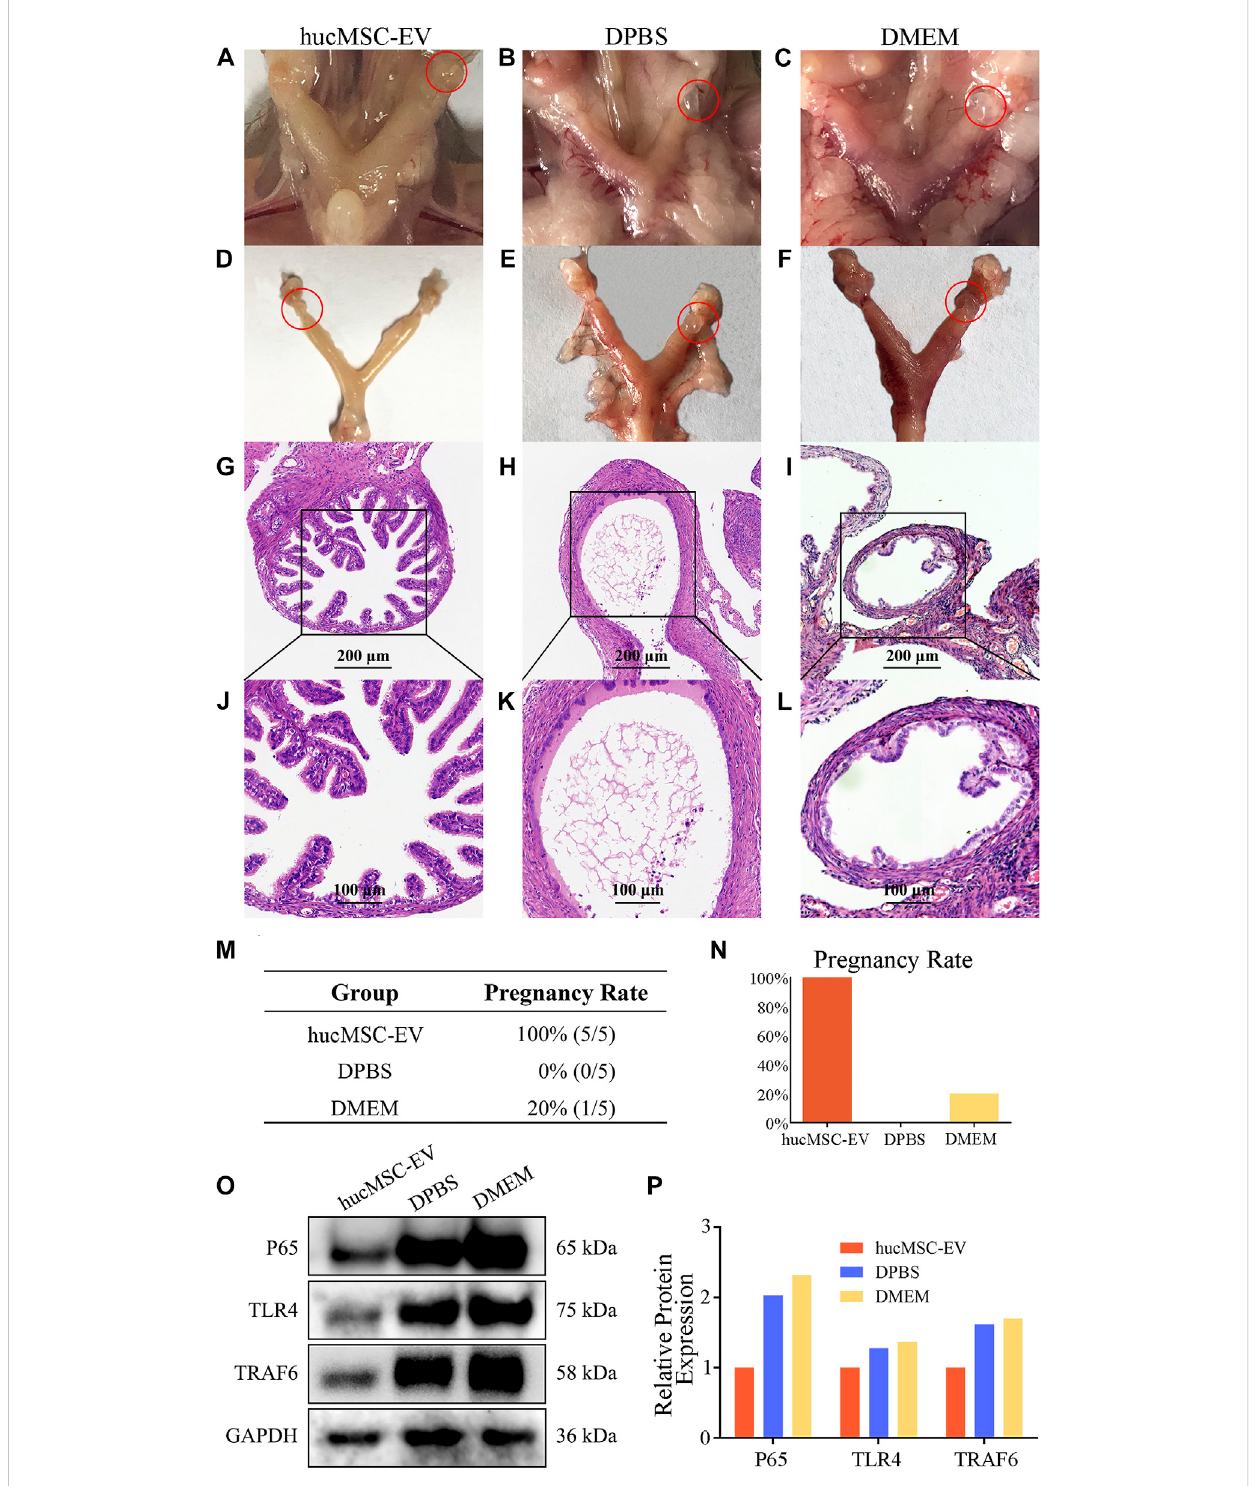
FIGURE 3 ThetherapeuticeffectofhucMSCsonamurinemodelofchronicsalpingitisandmolecularmechanism. (A – L) RepresentativephotographsandH&E microphotographs of mice fallopian tubes in the murine chronic salpingitis model. (M, N) The pregnancy rate table and graph of each group. (O, P) Representative western blots of P65 and TLR4 in the mice fallopian tubes from each group (O) and the relative protein expression (P) ; band intensities were normalized against the corresponding